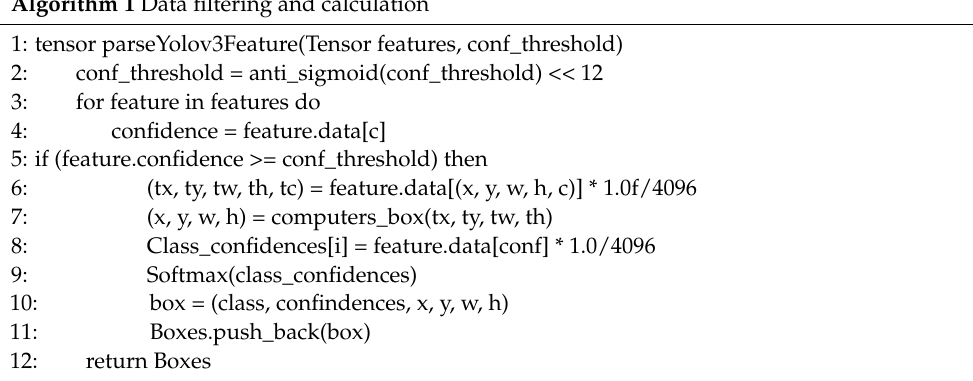
are the absolute coor-